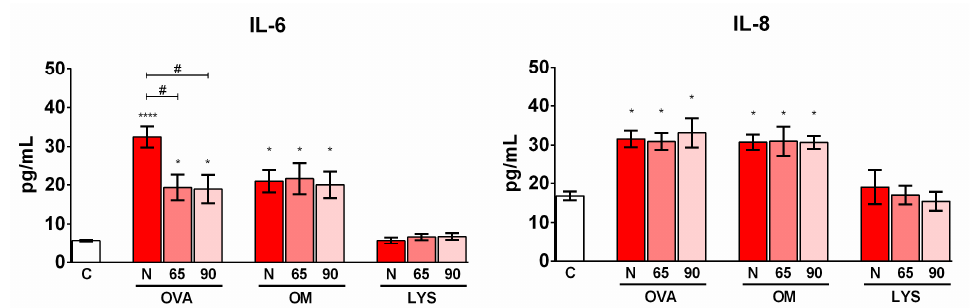
Figure 3. Secretion of IL-6 and IL-8 by Caco-2 cells after incubation with peptides (<10 kDa) generated during digestion of native (N) egg white proteins or subjected to two different heat treatments, 65 °C for 30 min (65) and 90 °C for 3 min (90). Asterisks and pounds indicate statistically significant differences with respect to the cells incubated with PBS (C) or between experimental groups, respectively. * and # p < 0.05; **** p < 0.0001.